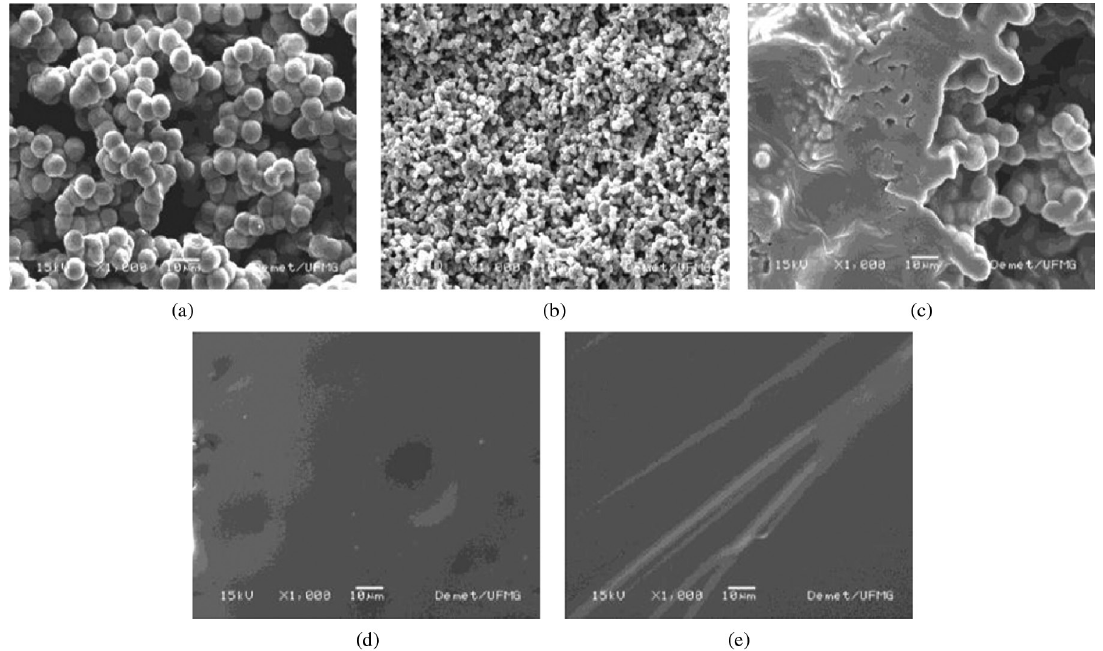
Figure 3. SEM images of the cryogenic fracture surfaces of the PVDF (a), PVDF/PHEMA/LiClO (c), (25/65/10) (d), and PHEMA